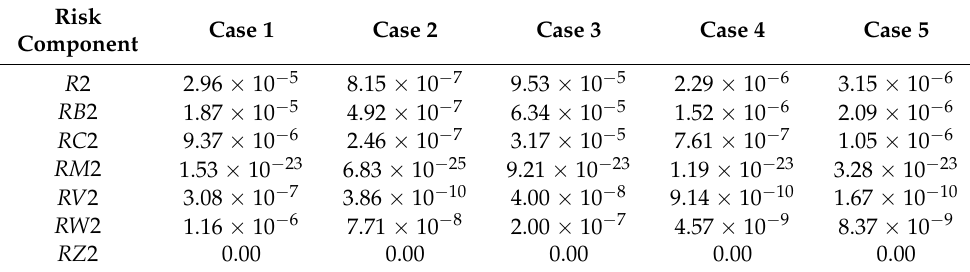
Table 19. Result of Risk Value of Loss of Service to the Public ( R 2)